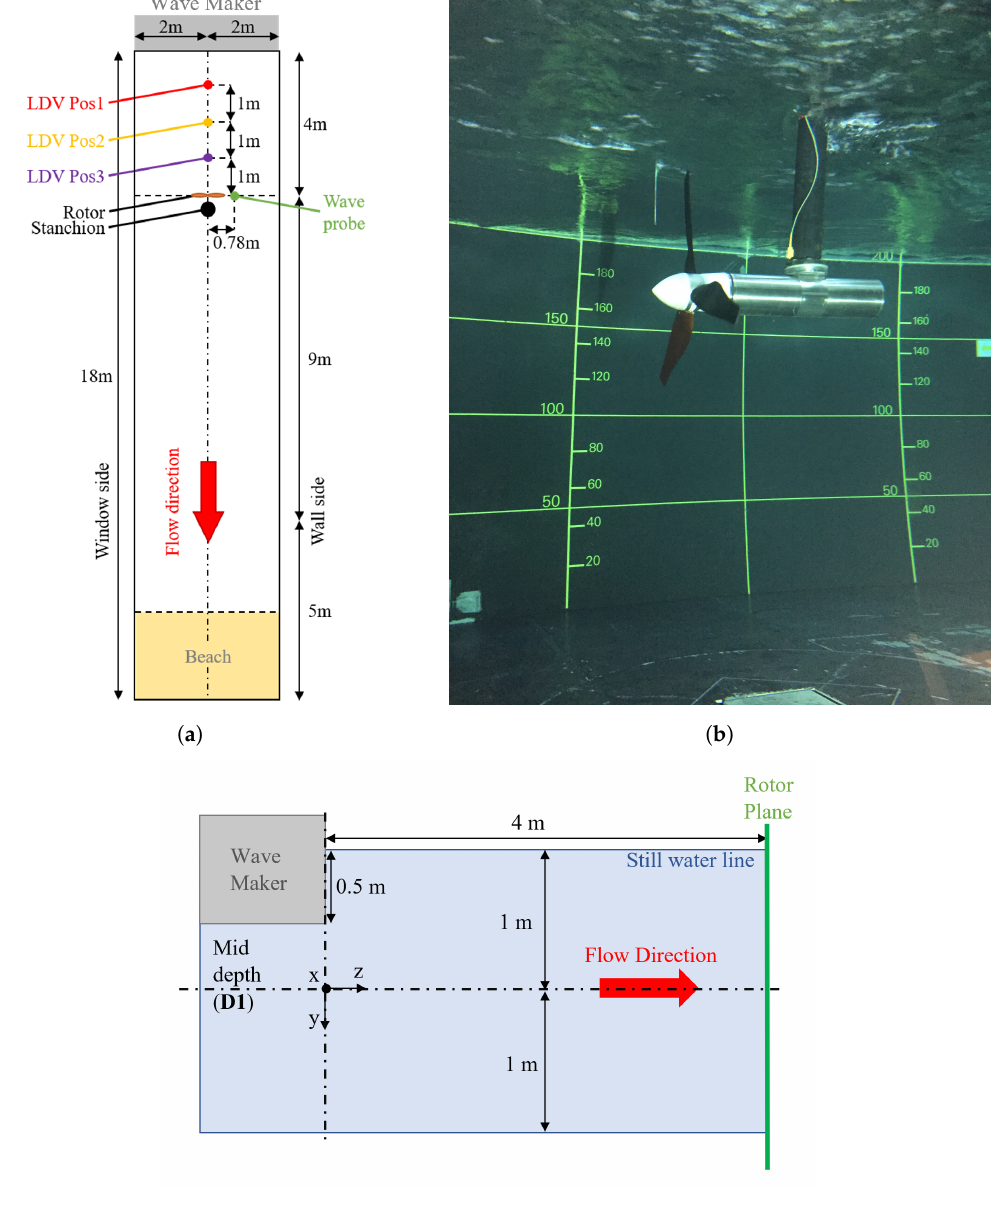
Figure 1. Schematics and photographs of the experimental setup. ( a ) Plan view schematic of the experimental setup showing the upstream LDV positions. ( b ) Photograph of the setup showing the instrumented turbine and the wave probe. ( c ) Side view of the setup showing the wave marker submersion depth, with the depth labelling convention